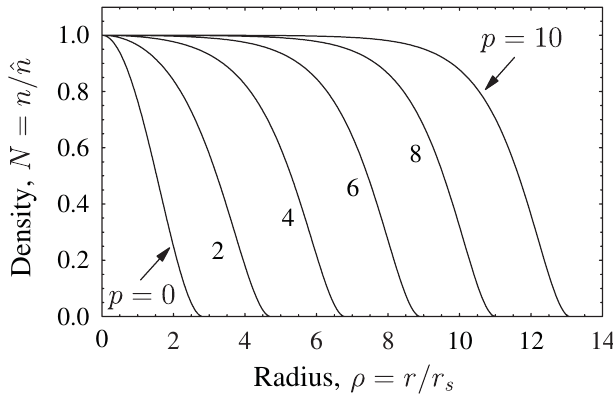
FIG. 13. For a parabolic equilibrium, the scaled density N ¼ n= ^ n is plotted versus the scaled radial coordinate (cid:12) ¼ r=r numerically calculated from Eqs. (E12) and (E13) for p ¼ 0 ; 2 ; . . . ; 10